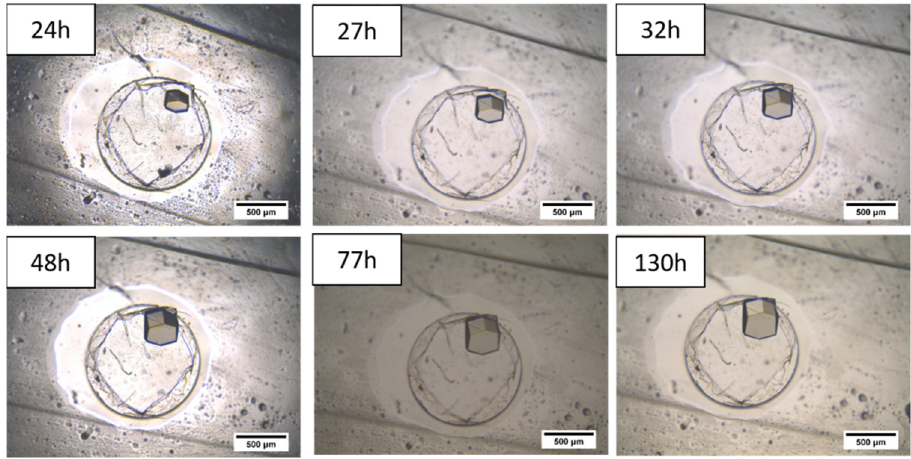
Figure 10. HEWL crystals evolution in the well-type micro-contactor when using the 117 Nafion ® membrane in its sodium form.